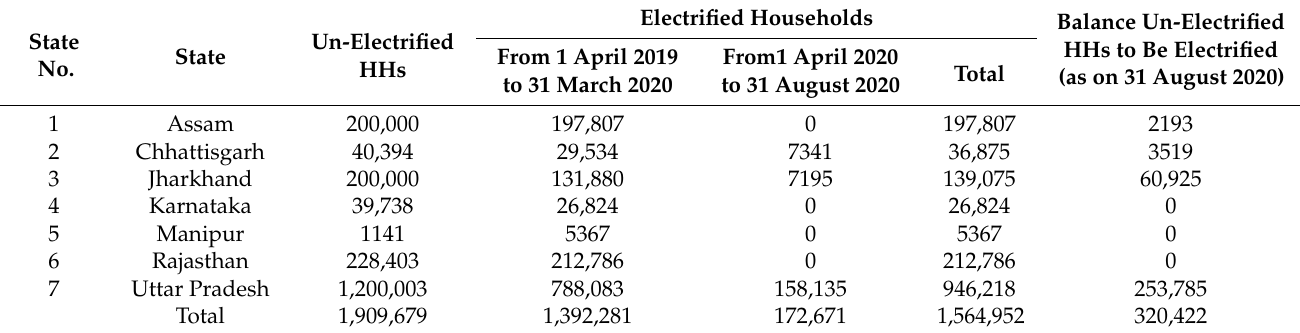
Table 6. Households per state that were electrified under Saubhagya since launch of the scheme, i.e., 11 October 2017 to 31 March 2019. Source: Ministry of Power, Central Electricity Authority, Government of India [44].